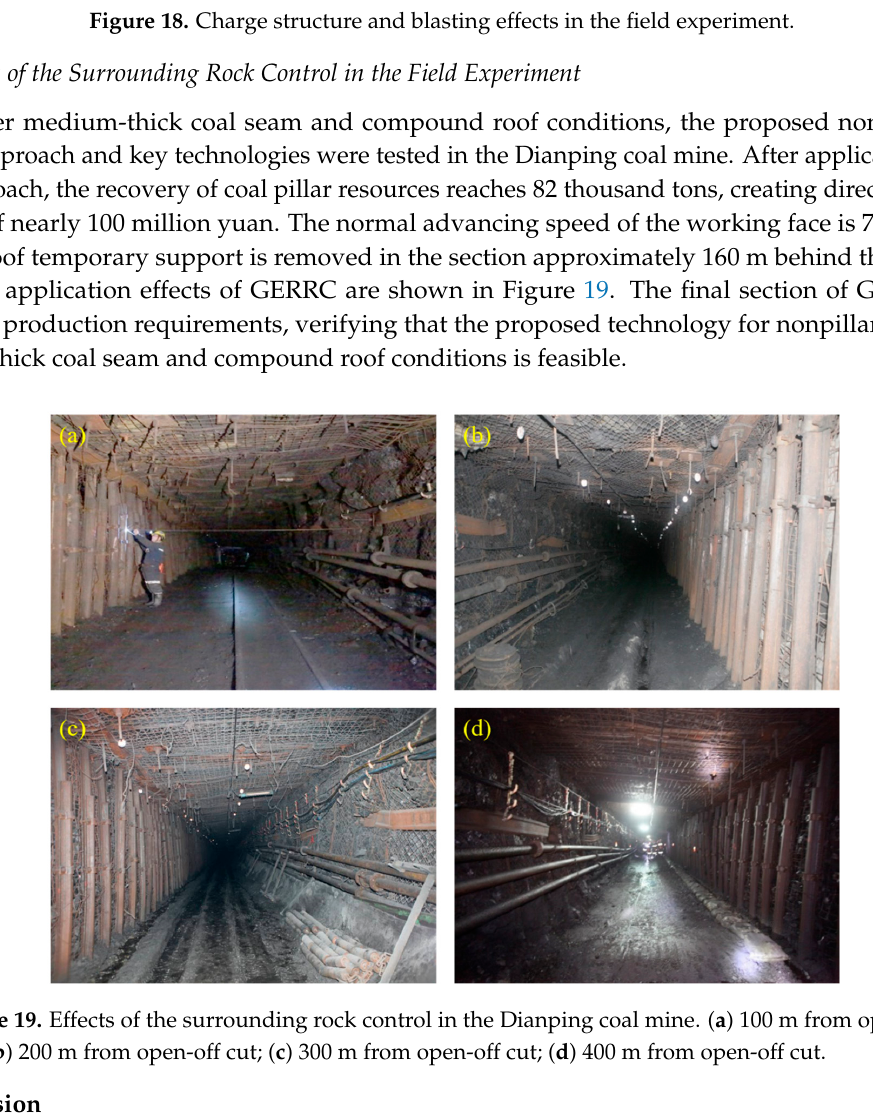
Figure 18. Charge structure and blasting effects in the field experiment.